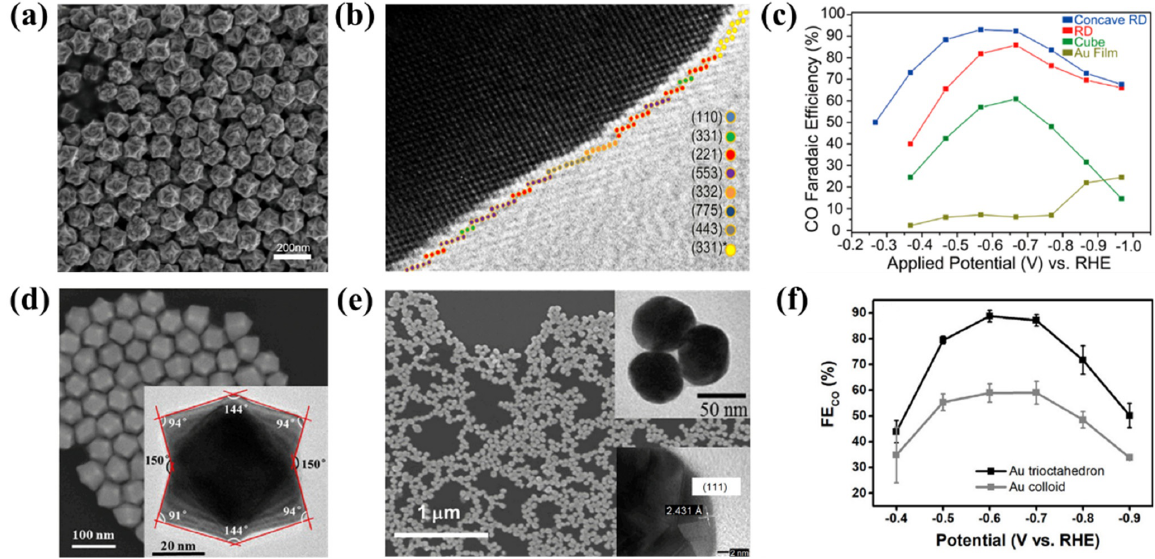
Figure 7. ( a ) SEM images of concave rhombic dodecahedral gold nanocrystals. ( b ) Atomic structures of a rhombic dodecahedron. ( c ) Potential-dependent Faradaic efficiency of concave rhombic dodecahedral, rhombic dodecahedral, cubic gold nanocrystals and gold films. Reproduced with permission from Ref. [97]. Copyright 2015, American Chemical Society. ( d ) SEM images of 50 nm Au TOH. ( e ) SEM images of Au colloids. ( f ) Faradaic efficiencies for CO as function of potential. Reproduced with permission from Ref. [98]. Copyright 2020, Elsevier.